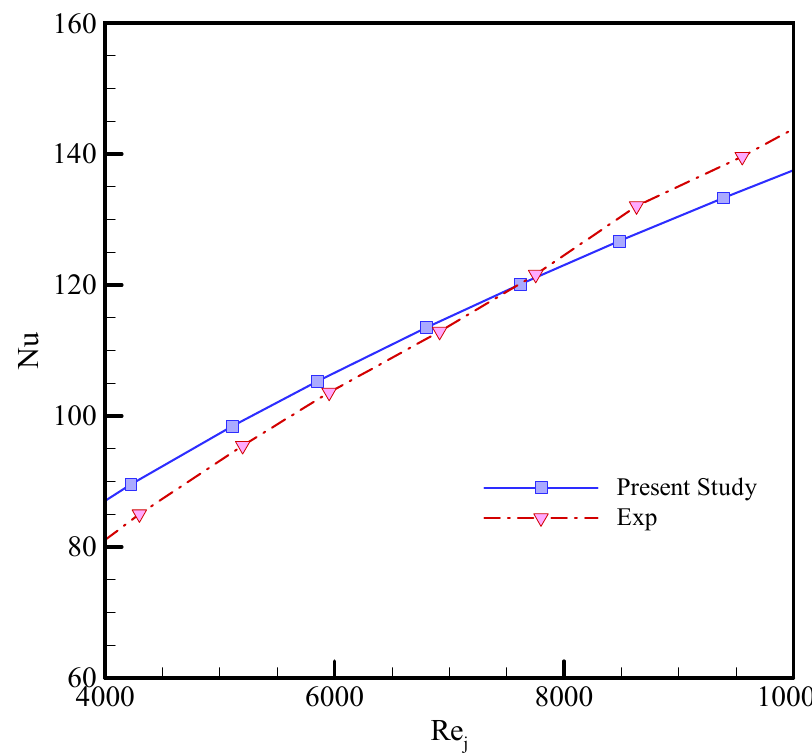
Figure 5. Numerical model validation by comparing with the results reported by [36] for NEPCM slurry (with 28% particle volume fraction) as coolant.